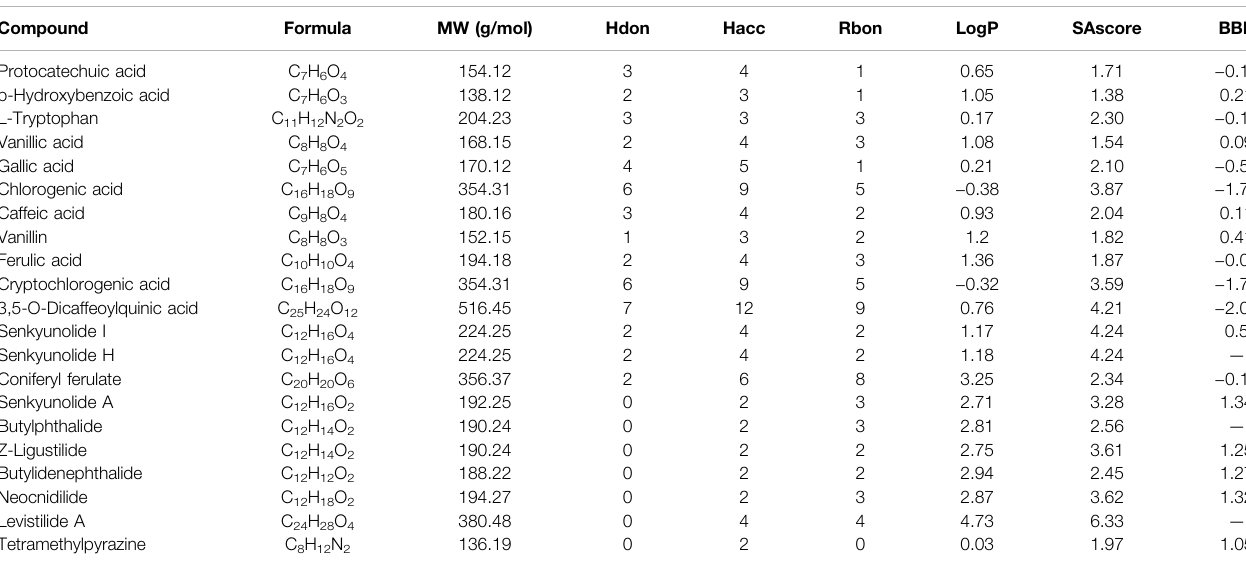
TABLE 1 | 21 Main phytochemicals in CR and their